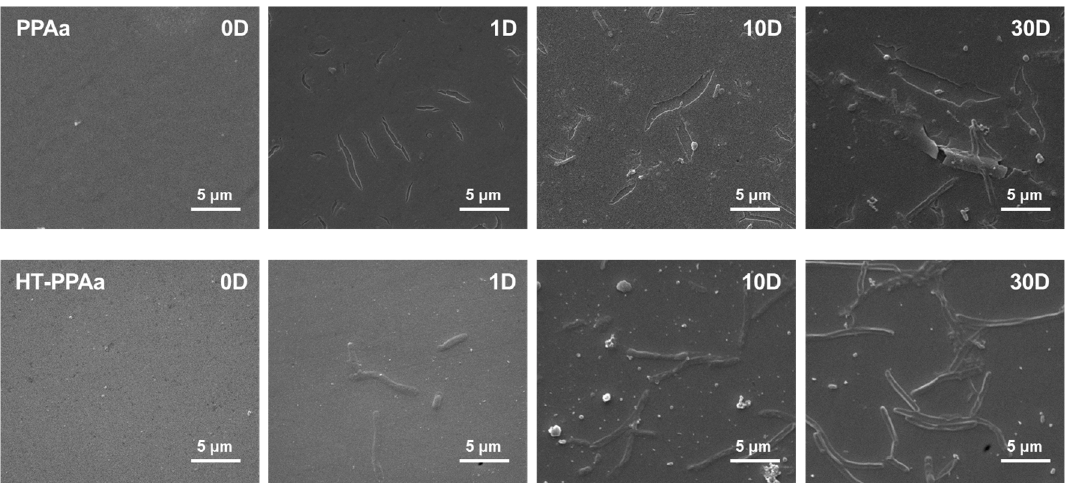
Figure 6. The SEM images of PPAa film and HT-PPAa film immersed into the phosphate-buffered saline (PBS) solution for 30 days.